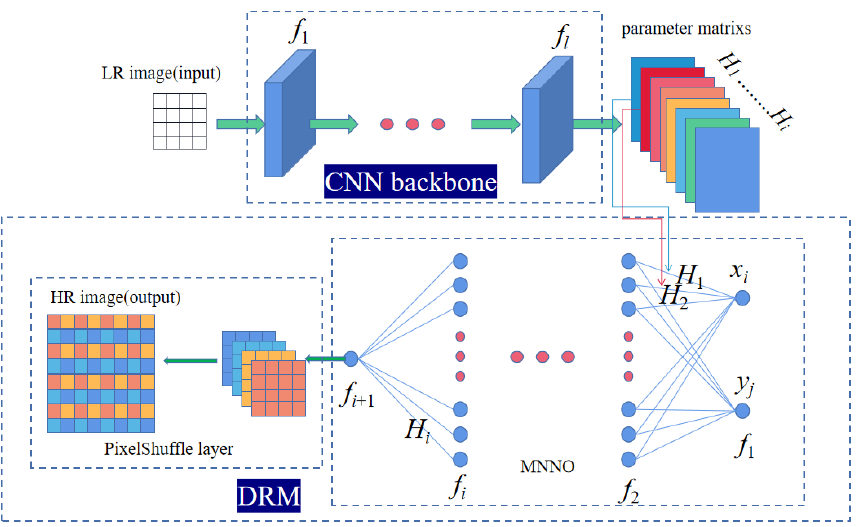
Figure 3. The proposed LDRN consists of the CNN backbone and the DRM. The CNN backbone is used to generate the parameter matrix, and the DRM is used to generate the HR